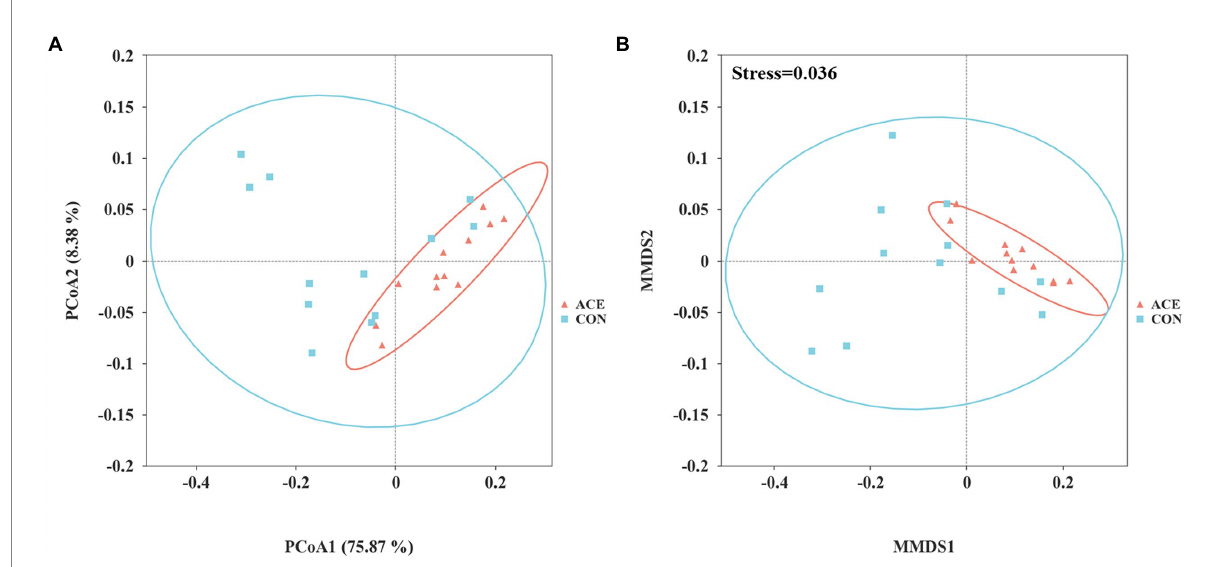
FIGURE 1 Beta community diversity analysis of the CON and ACE groups of rumen microbiota. (A) Principal coordinate analysis (PCoA) and (B) non-metric multidimensional scale analysis (NMDS) CON = control group, basal diet plus 468 g/day oral sodium chloride; ACE = NAc group, basal diet plus 656 g/day oral NAc.